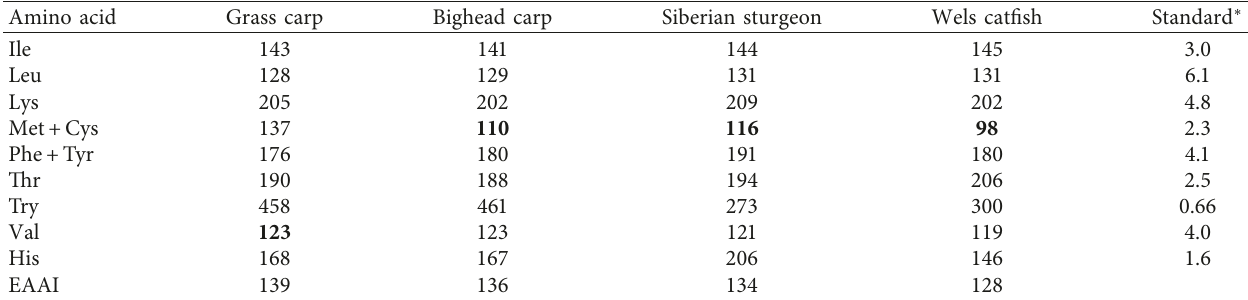
Table 4: CS (Chemical Score) and EAAI (Essential Amino Acid Index) for protein of grass carp, bighead carp, Siberian sturgeon, and wels catfish